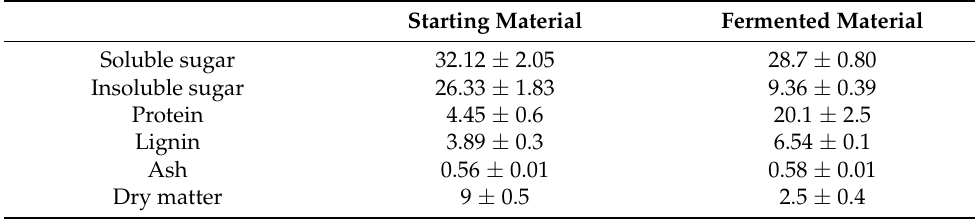
Table 1. Fermentation medium composition a .